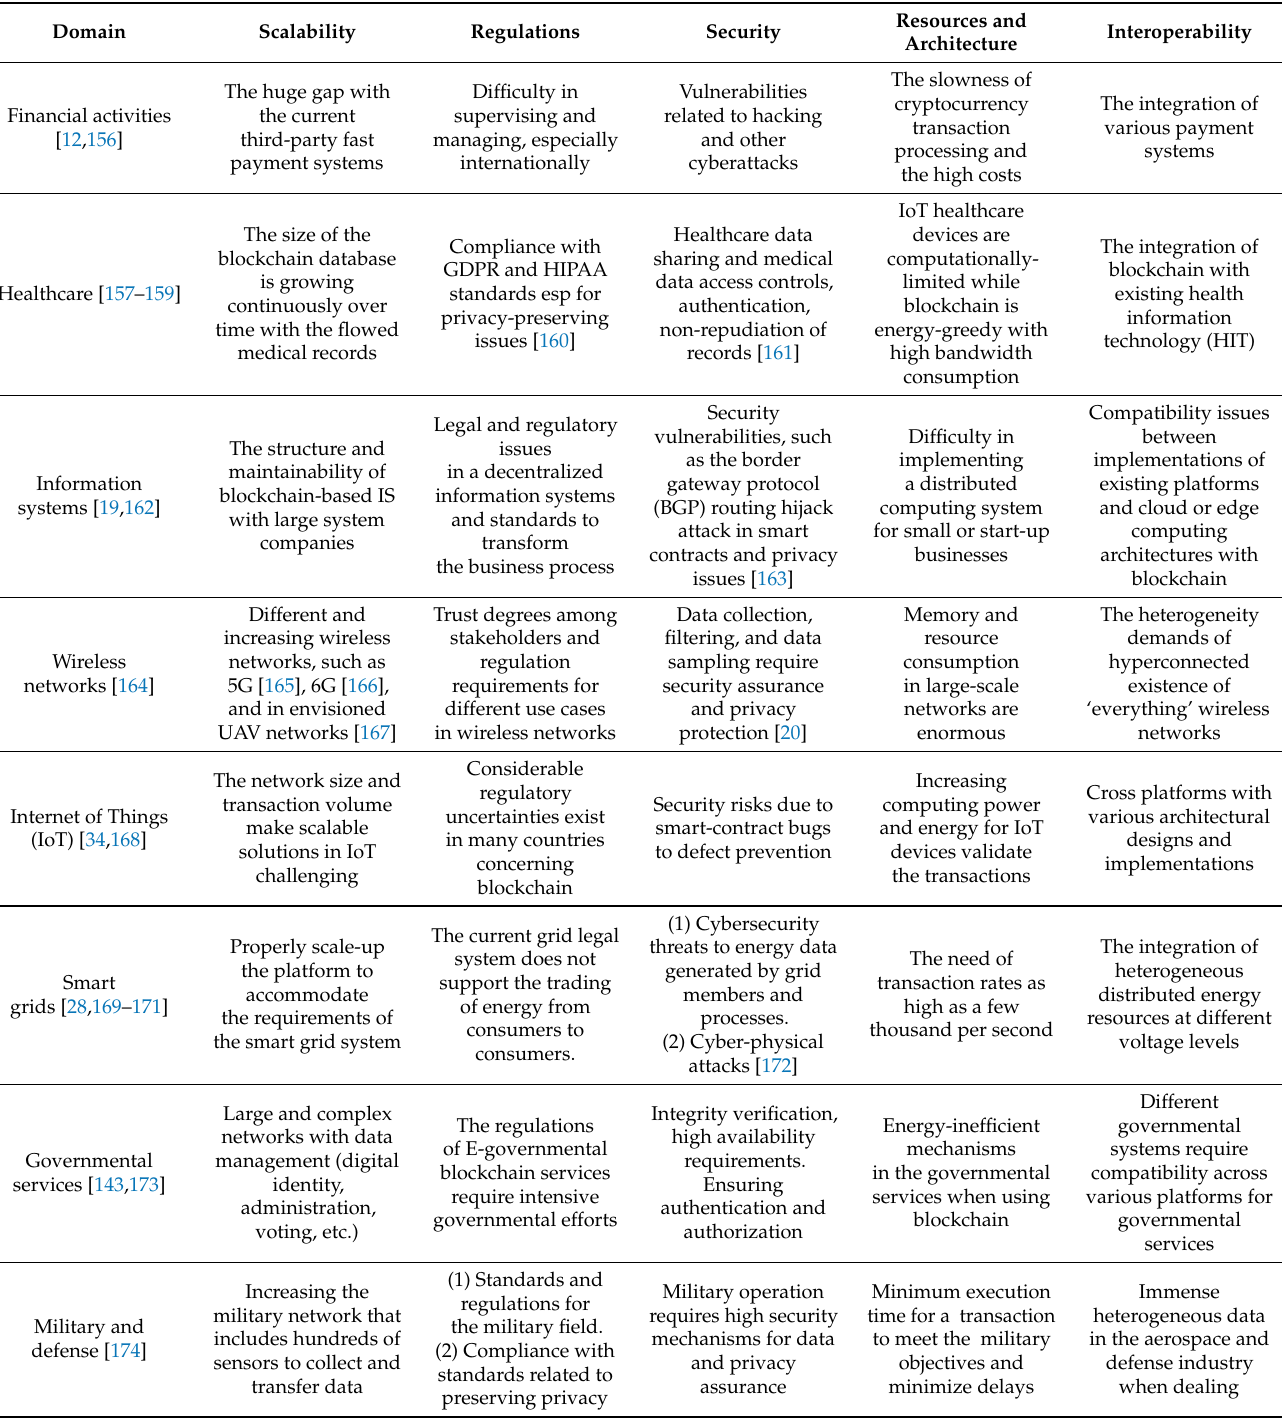
Table 3. Summary of the main challenges associated with the use of blockchain